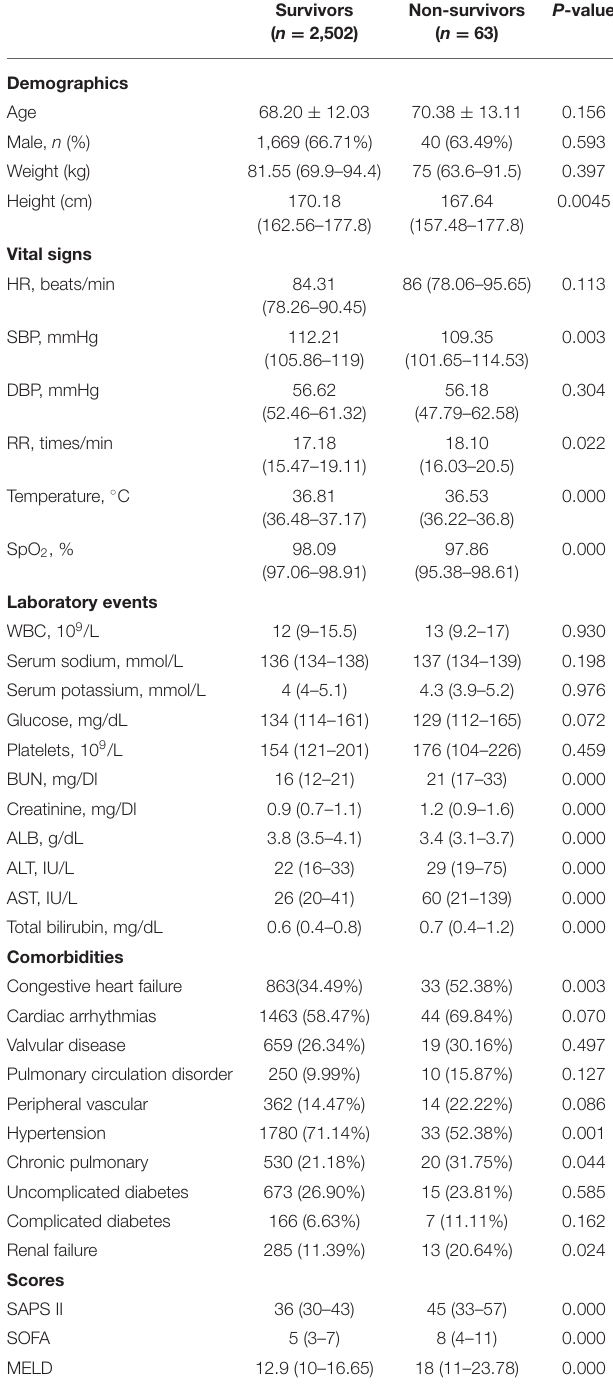
Values are presented as the mean ± standard deviation, median (interquartile range), or the number of patients (%). ALB,bloodalbumin;ALT,bloodalaninetransaminase;AST,bloodaspartatetransaminase; BUN, blood urea nitrogen; HR, heart rate; SBP, systolic blood pressure; DBP, diastolic bloodpressure;RR,respiratoryrate;SpO 2 ,percutaneousoxygensaturation;WBC,white blood cell; SAPS II, Simplified Acute Physiology Score II; SOFA, Sequential Organ Failure Assessment. MELD, Model end-stage liver